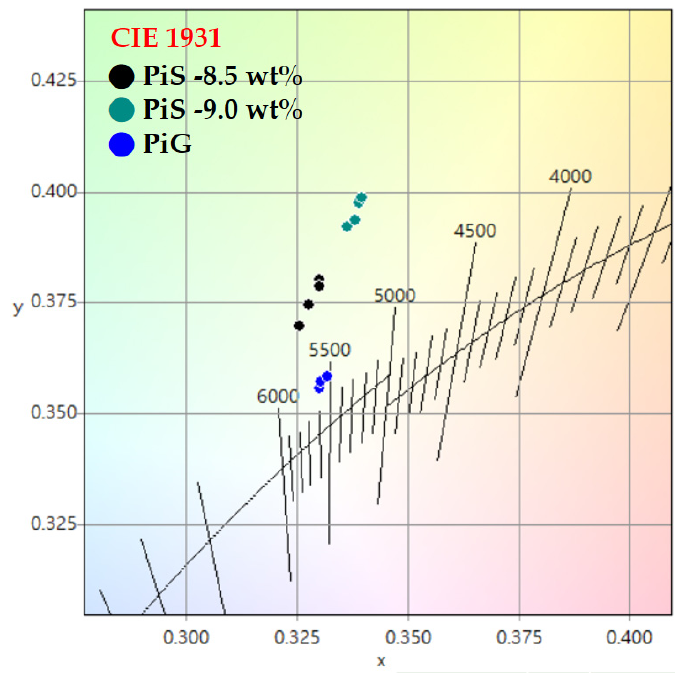
Figure 2. PiS WLED doped with 8.5 and 9 wt.% yttrium aluminum garnet (YAG) phosphors and the PiG WLED CIE coordinate distribution of the covered PiG. Table 1. Light properties of PiS WLED doped with 8.5 and 9 wt.% YAG phosphors and PiG WLED covered with phosphor glass.